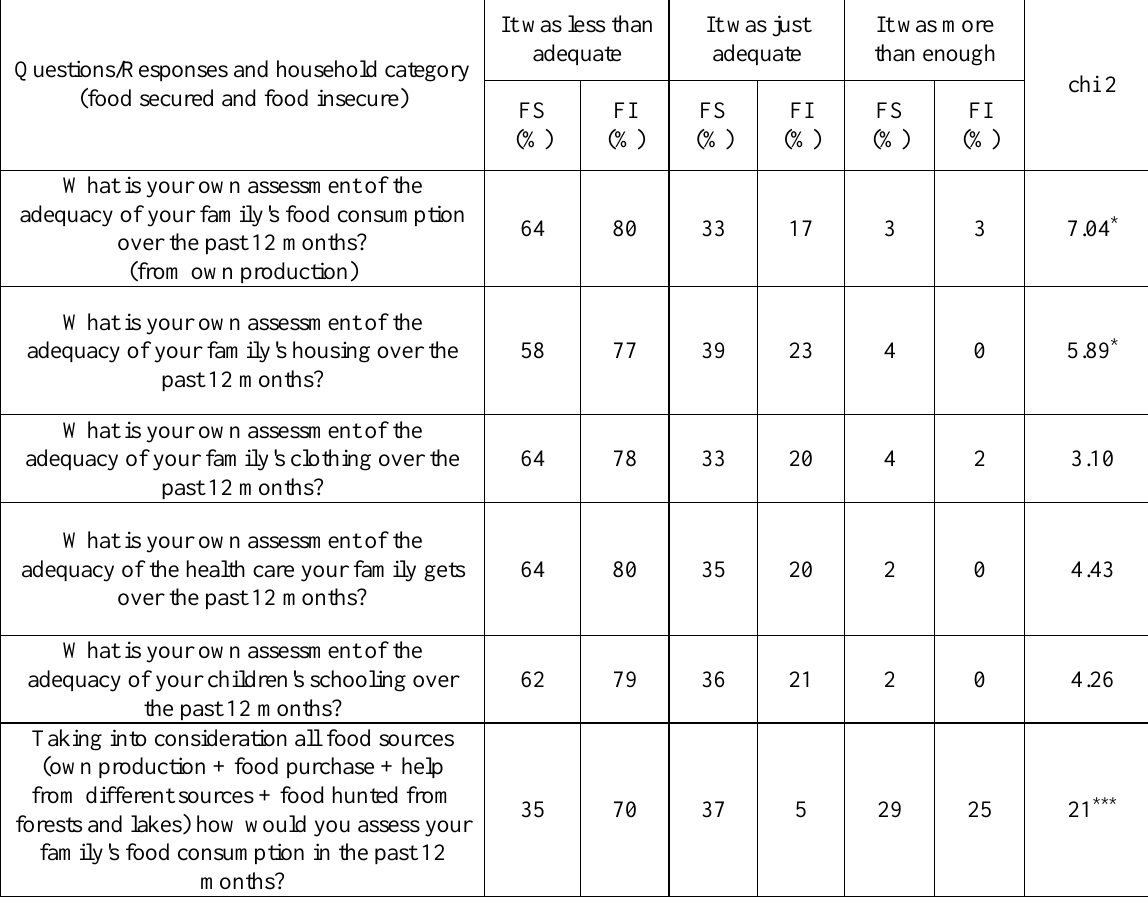
Table 12. Percentage of sample households responded as “Yes” for the food insecurity access scale questions including non-food consumption for family need in the last 12 months